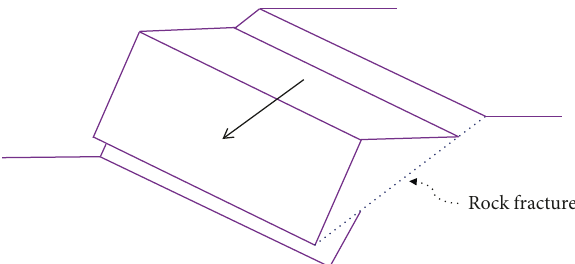
Figure 1: Illustration of plane failure along rock fracture of rock